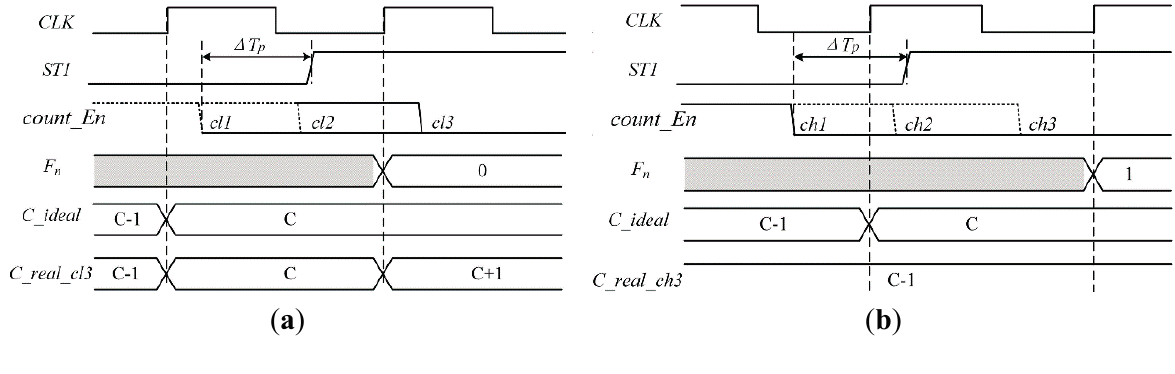
Figure 10. Timing diagram of the proposed calibration circuit. ( a ) ST 1 rises at the low level state of clock; ( b ) ST 1 rises at the high level state of clock ( C_ideal denotes the ideal output of coarse quantization; C_real denotes the actual output of coarse quantization).